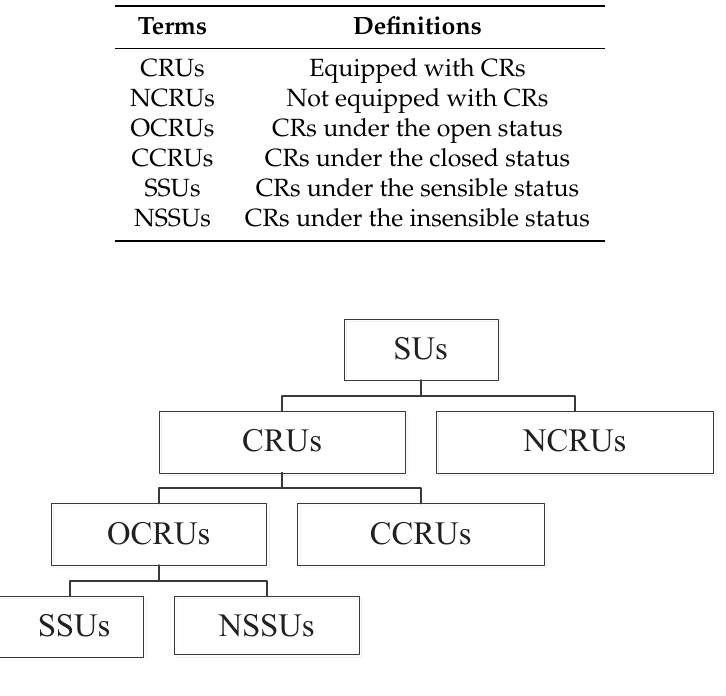
Figure 2. The relationship between different types of